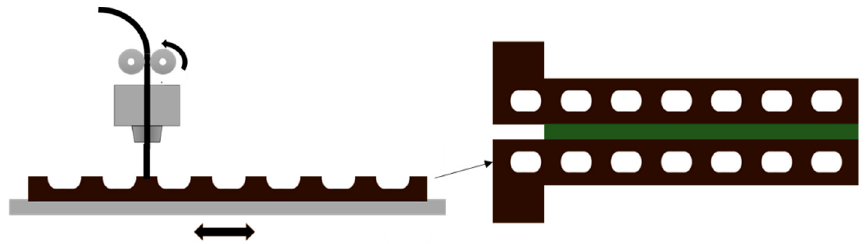
Figure 6. Adherend bio-inspired stiffness tailoring using a sub-surface geometry as proposed in [33– 35].